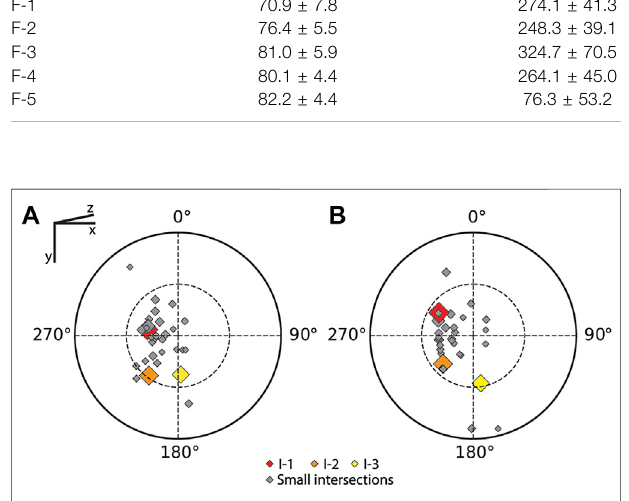
FIGURE 10 | Equal area, lower hemisphere stereographic projections illustrating (A) the orientations of lines of best fi t to the separated fracture intersections found during the fracture separation analysis. (B) Stereonet of the same lines of intersection calculated from the intersections of the boundingplanes. Lengths oftheintersectionsareillustrated both bycolorand symbol size.